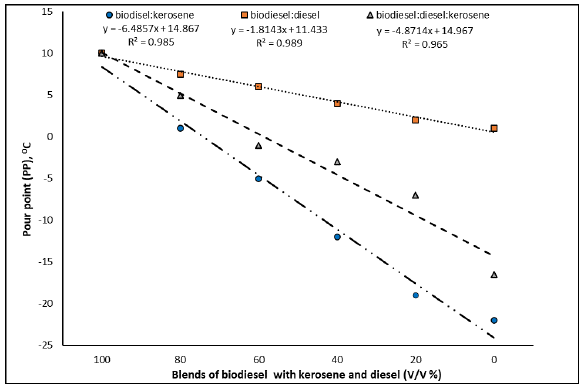
Fig. 3. Effect of Neem biodiesel ratio on PP of